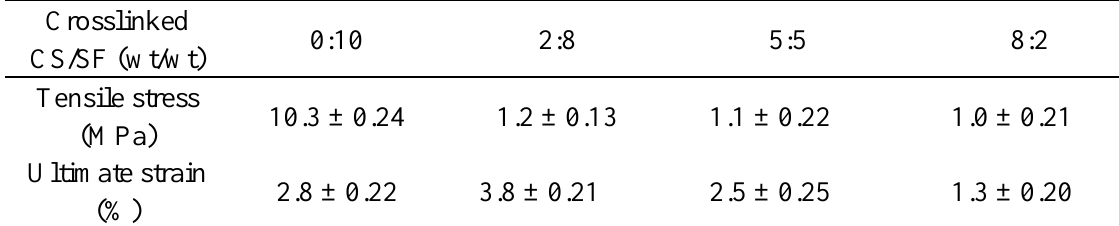
Table 1. Mechanical Properties of Cross-Linked CS/SF composite nanofibrous